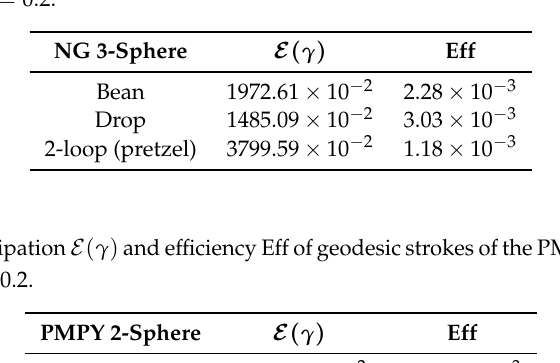
Figure A1. Geodesic strokes of NG 3-sphere and PMPY 2-sphere swimmers. ( a ) The γ -paths of the geodesic strokes of the NG 3-sphere swimmer, with X ( γ ) = 0.045 and ε = 0.2. (b ) The geodesic stroke trajectories from ( a ). ( c ) The γ -paths of the geodesic strokes of the PMPY 2-sphere swimmer, with X ( γ ) = 0.1 and ε = 0.2. ( d ) The geodesic stroke trajectories from ( c ). Table A1. Energy dissipation E ( γ ) and efficiency Eff of geodesic strokes of the NG-3sphere swimmer, with X ( γ ) = 0.045, ε = 0.2.